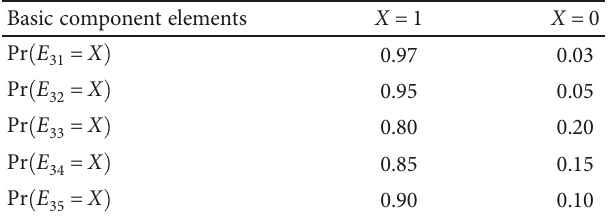
Table 3: Predetermined CPTs.